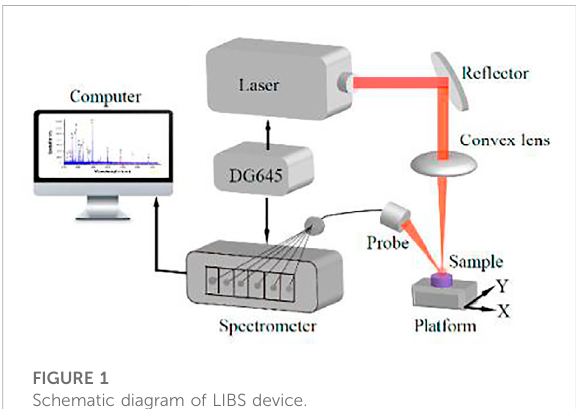
FIGURE 1 Schematic diagram of LIBS